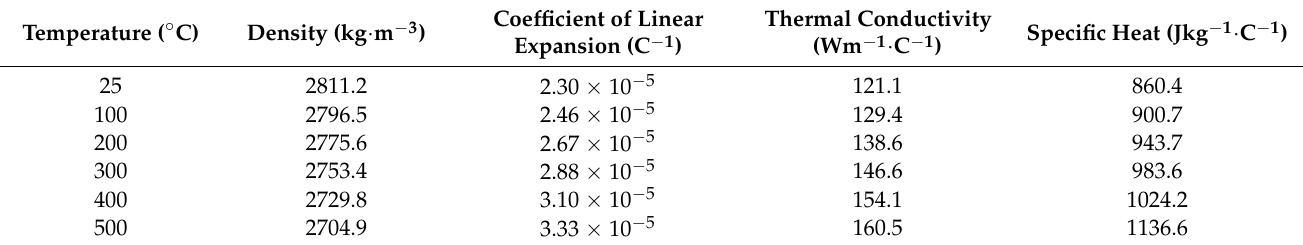
Table 2. Considered thermal properties of 7075 aluminum with respect to temperature.